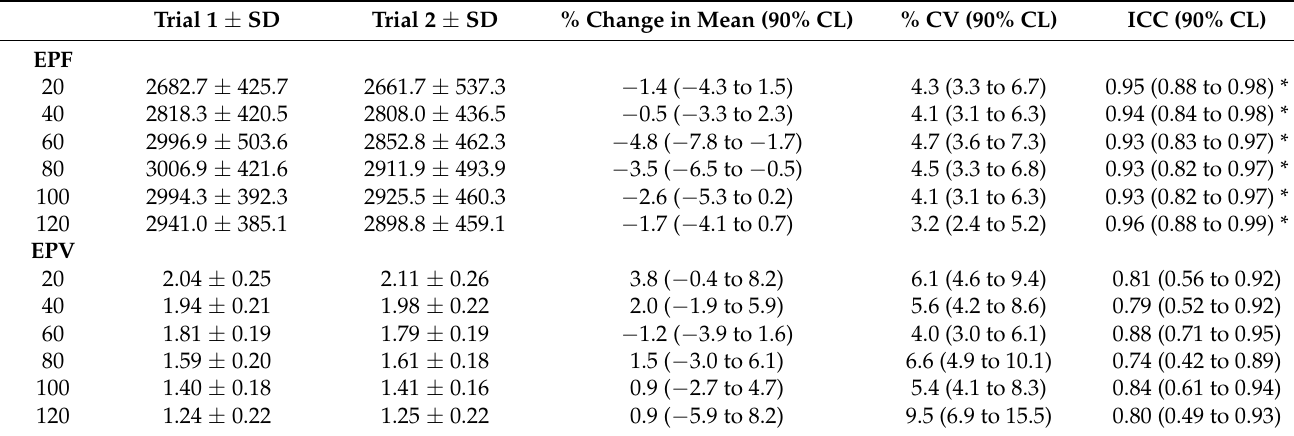
Table 2. Between-session reliability for eccentric force-time-displacement variables obtained with different loads in the back